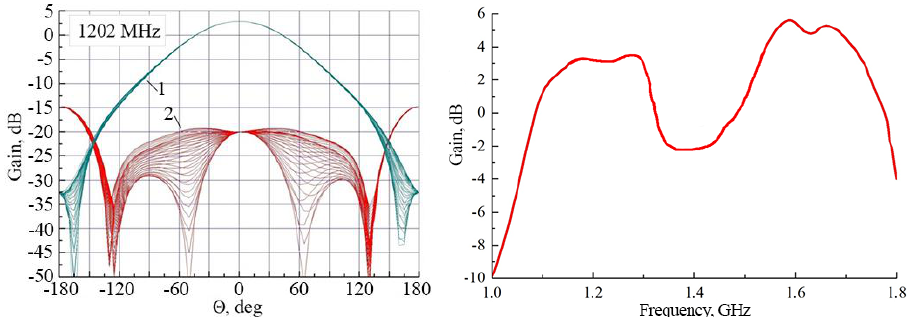
Fig. 3. Simulated radiation patterns. Fig. 4. Simulated gain of the proposed antenna.